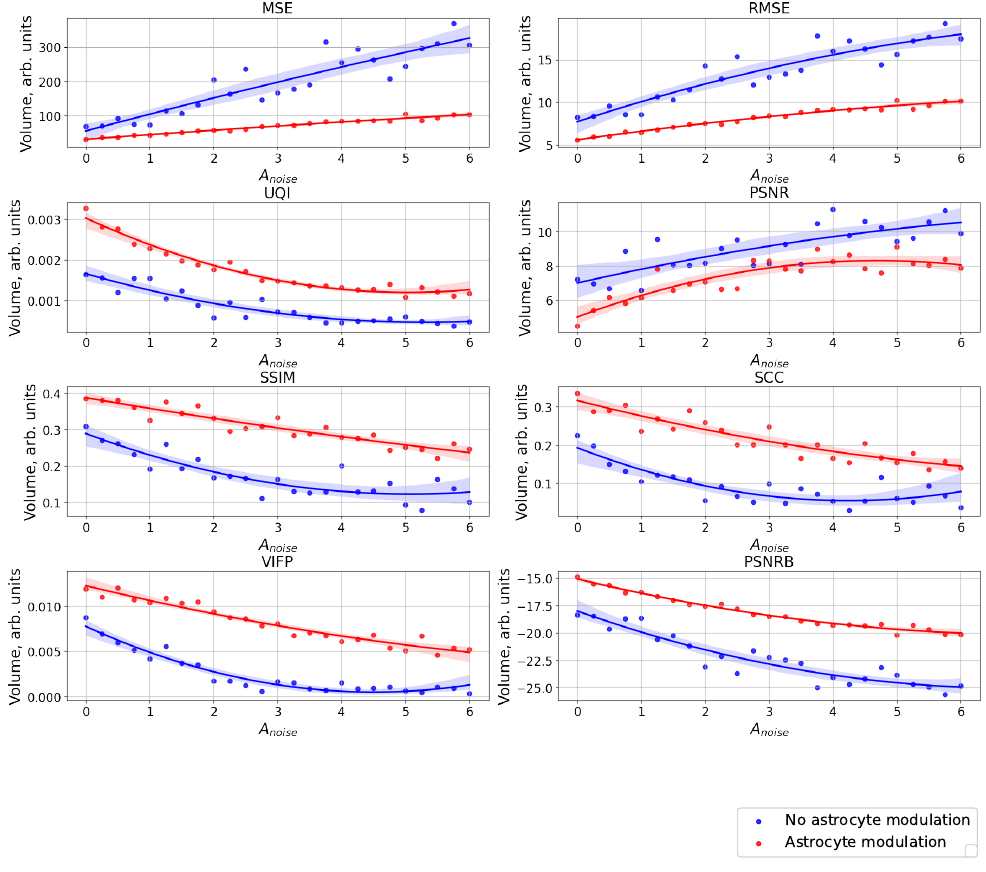
Figure A8. The case of using quality metrics—MSE, RMSE, UQI, PSNR, SSIM, SCC, VIFP, and PSNRB—for comparing raster diagrams of neural activity from Figures A6 and A7 with an image (middle panel of Figure A5) fed to a spiking neural network with an increase in the amplitude, A noise , of the noise signal from 0 to 6 supplied to the neurons of the neural network without astrocytic modulation (blue dots and curve) and with astrocytic modulation (red dots and